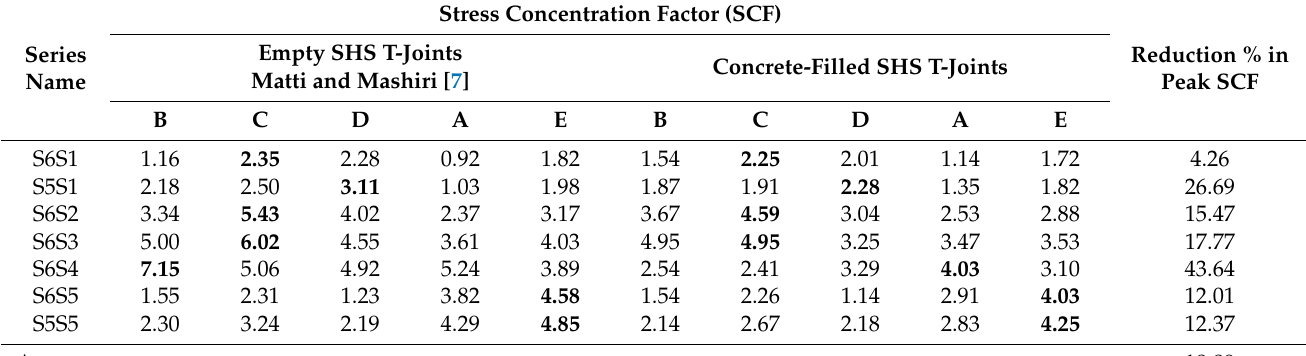
Table 8. Numerical SCFs of concrete-filled T-joints under in-plane bending.